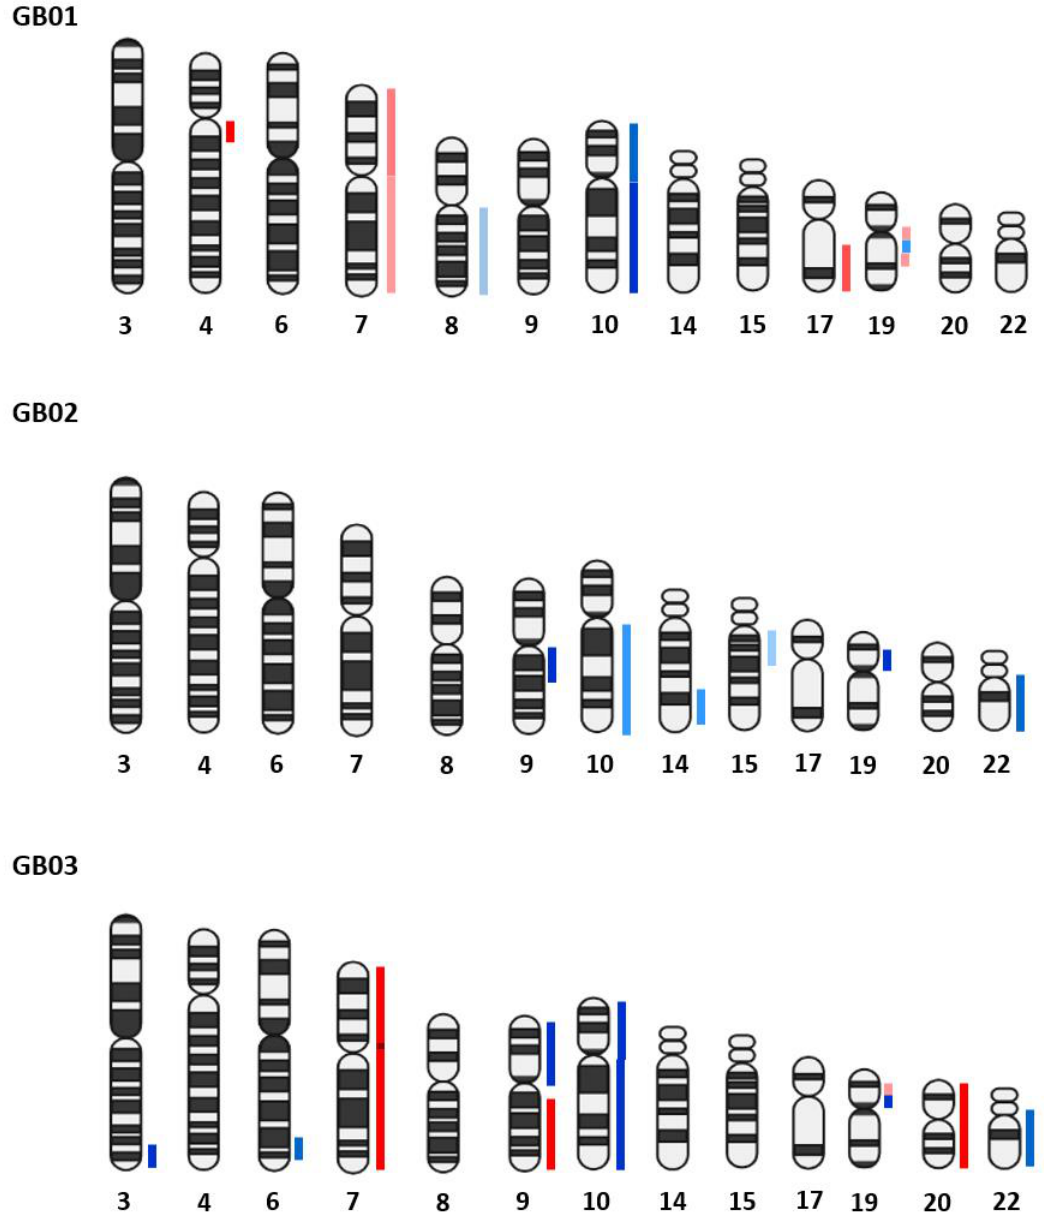
Figure 5. CNA pattern of the fresh GB tissues in bulk. The chromosomal amplifications are shown in red, and in blue the deletions. The intensity of the red and blue color components correlates with the gain and loss values based on the results obtained from the CNApp tool.